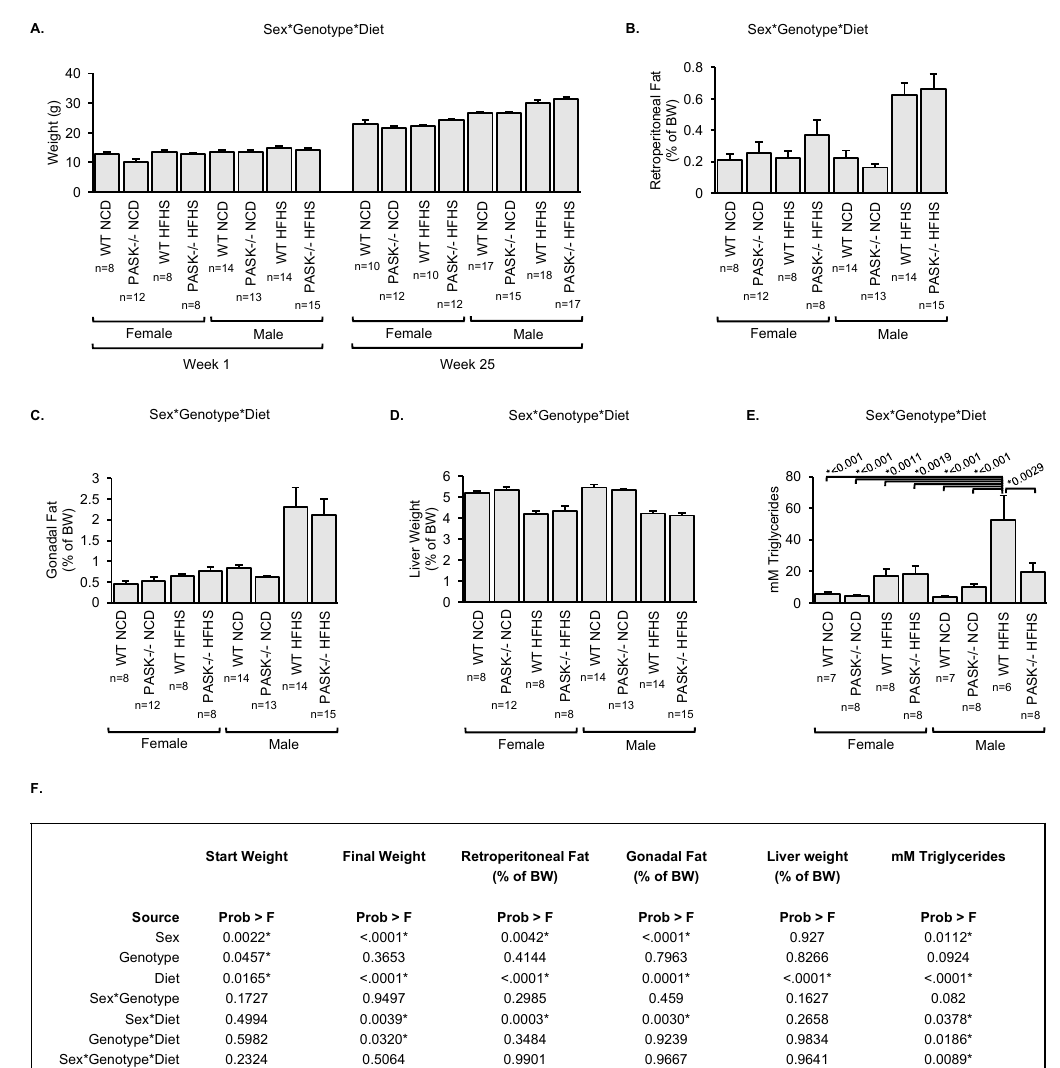
Figure 3. PAS kinase deficiency (PASK − / − ) protects against HFHS-induced accumulation of hepatic triglycerides. ( A ) Body weight of male and female mice at the start of the diet (week 1, 12-week-old mice) and the end of the diet (week 25). ( B ) Retroperitoneal fat, ( C ) gonadal fat and ( D ) liver weight as a percentage of Body Weight (BW). ( E ) Hepatic triglyceride quantification for female and male mice using BioVision Triglyceride Quantification kit. ( F ) Factorial ANOVA analysis (sex, genotype, and diet) results for the data presented in ( A – E ). NC is Normal Chow diet, HFHS is High-Fat High-Sugar diet. For all figures, error bars represent SEM. Three-factor ANOVA was performed using JMP Pro14 software with Tukey post-hoc test for three-factor and two-factor (sex and genotype, sex and diet, or genotype and diet) comparisons and students t-test for one-factor (sex, genotype, or diet) comparisons. * p < 0.05 are shown in ( A – E ) for the three-factor analysis.